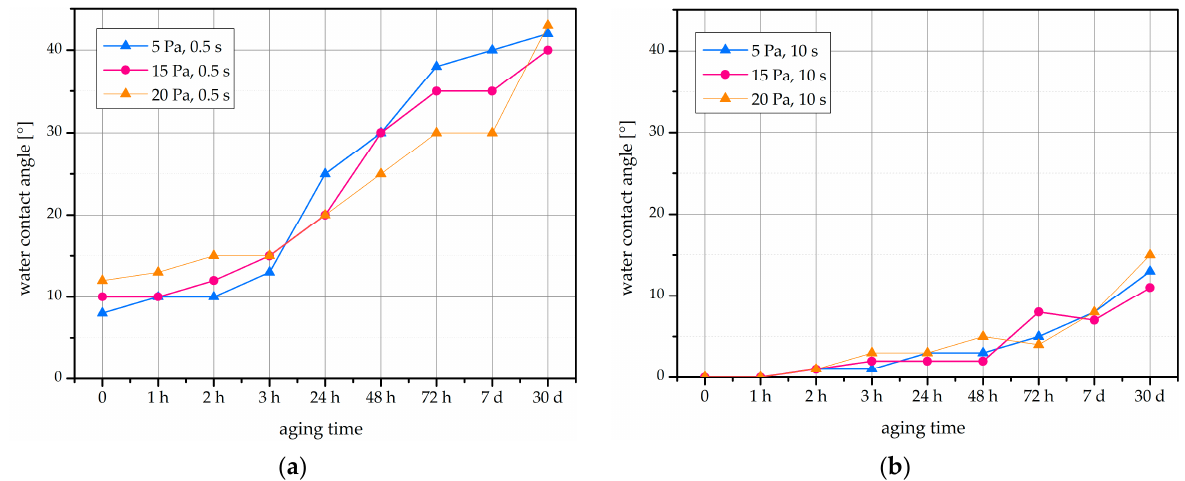
Figure 4. Hydrophobic recovery of the WCA on the surface of bean seeds. Recorded after plasma treatment for ( a ) 0.5 s or ( b ) 10 s at different gas pressures (5–20 Pa), followed by different times of ageing in ambient air conditions.